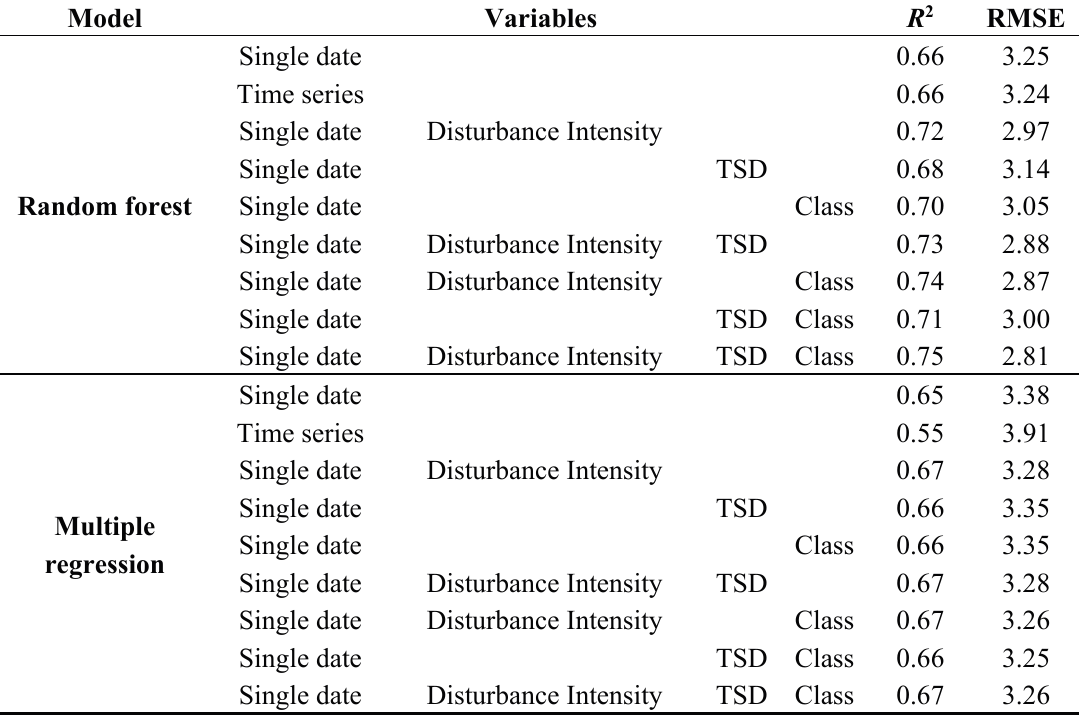
Table 4. Summary of MCH prediction using combination of variables with multiple regression and random